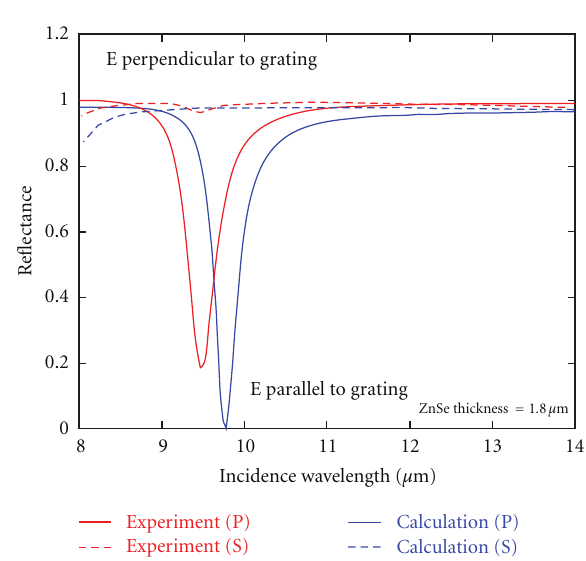
Figure 11: A comparison of predicted (using RCW code) and measured reflectance for both parallel (P type) and perpendicular (S type) polarizations.